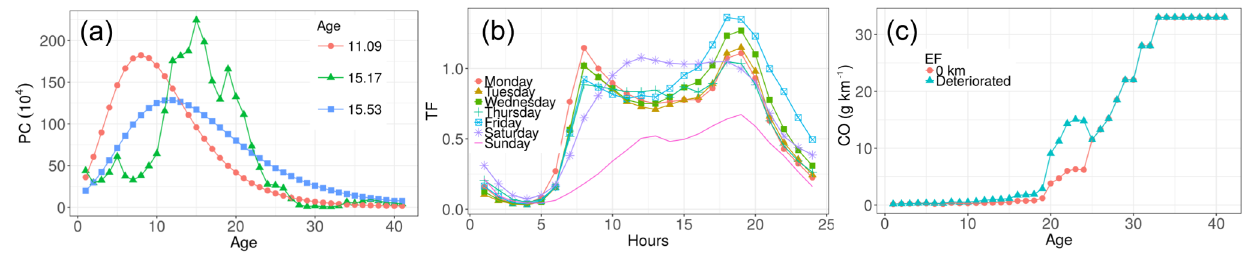
Figure 5. (a) Distribution of LDV composition by age of use, (b) temporal factor for expanding morning rush hour traffic data and (c) CO emission factors used in the estimation presented in this